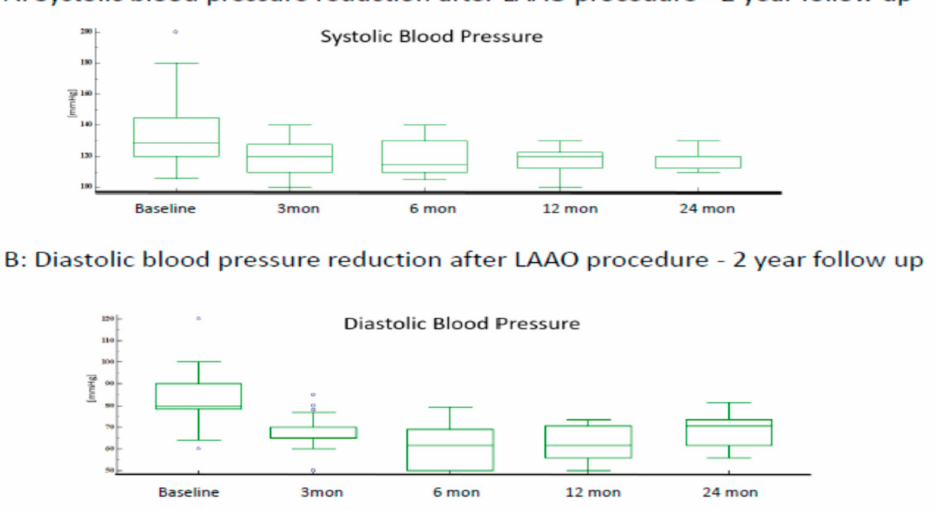
Figure 1. In a 2-year follow-up after LAAO procedure, mean SBP and DBP in our study is (119.4 ± 4.8 mmHg) and (73.2 ± 3.7 mmHg),